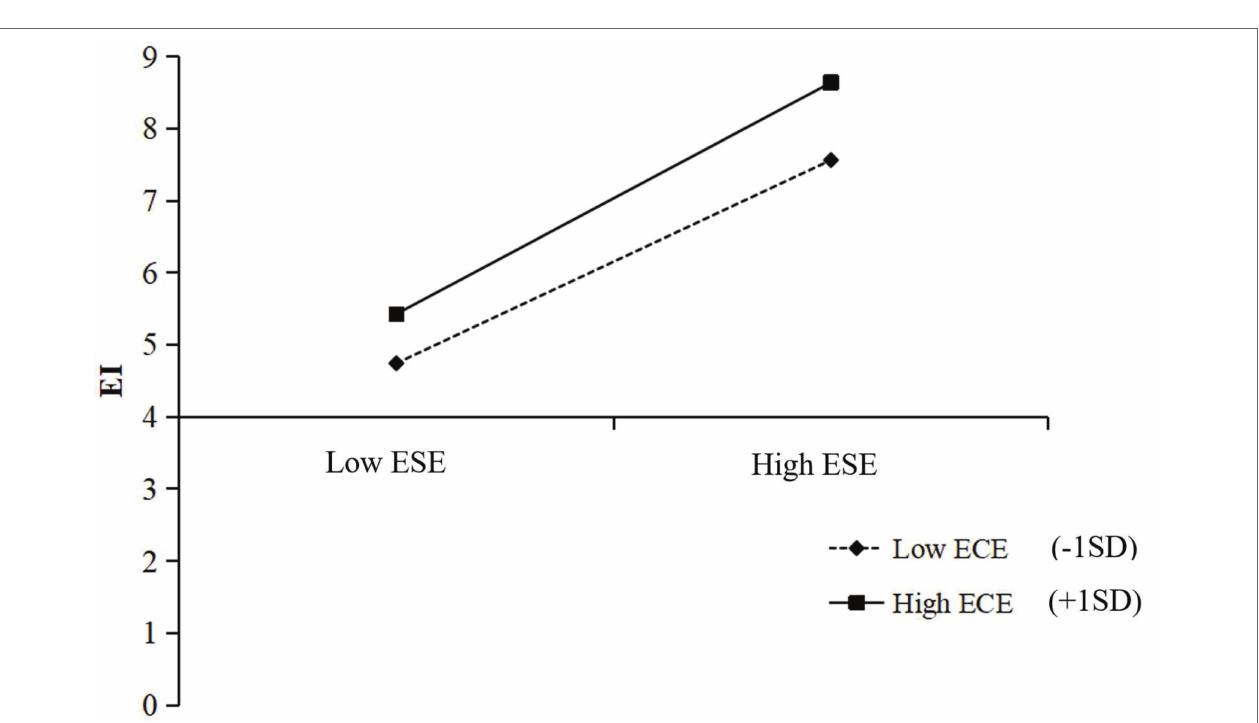
FIGURE 1 | Mediating effect model. *** means p < 0.001; ED, entrepreneurship education; ESE, entrepreneurial self-efficacy; EI, entrepreneurial intention.